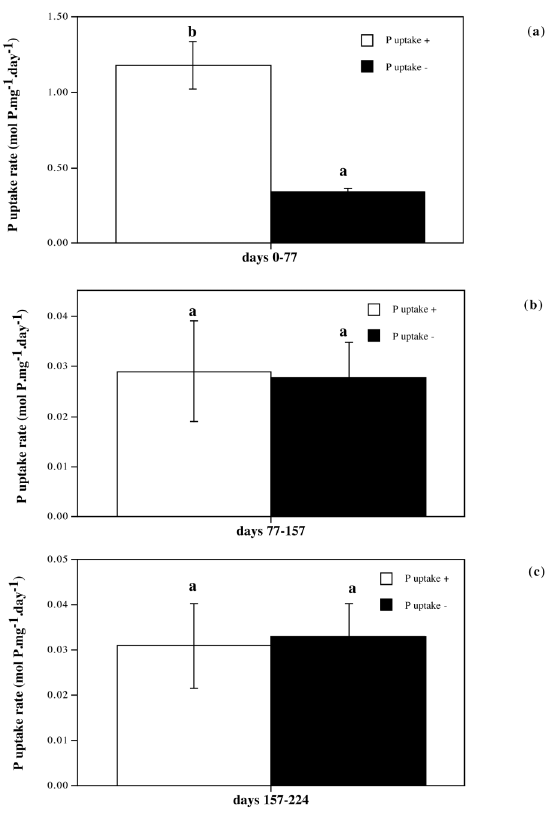
Fig. 4 . P-uptake rate (mol P mg –1 day –1 ), of Agathosma betulina for (a) the growth period 0–77 days, (b) the growth period 77– 157 days and for (c) the growth period 157–224 days. Differenc- es between arbuscular mycorrhizal inoculated (+AM) and non- AM (–AM) plants were determined by t-test for independent samples by groups. Statistically significant differences (p £ 0.05) between AM inoculated and non-AM plants for each growth pe- riod are indicated by different letters. Error bars represent mean ± SE (n = 4).